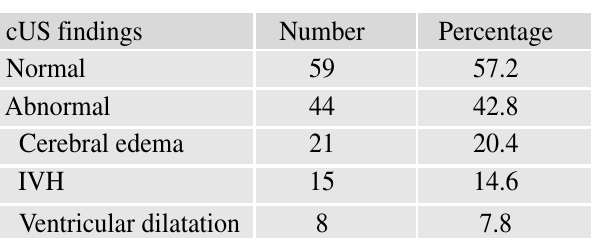
Table II: Cranial ultrasound (cUS) findings of the neonates immediately after admission